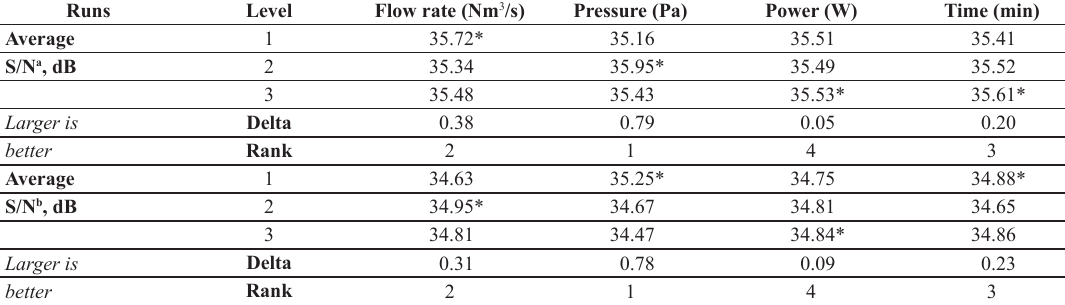
Table 2. Response table for mean of S/N ratio to optimize wickability of fabric. Runs